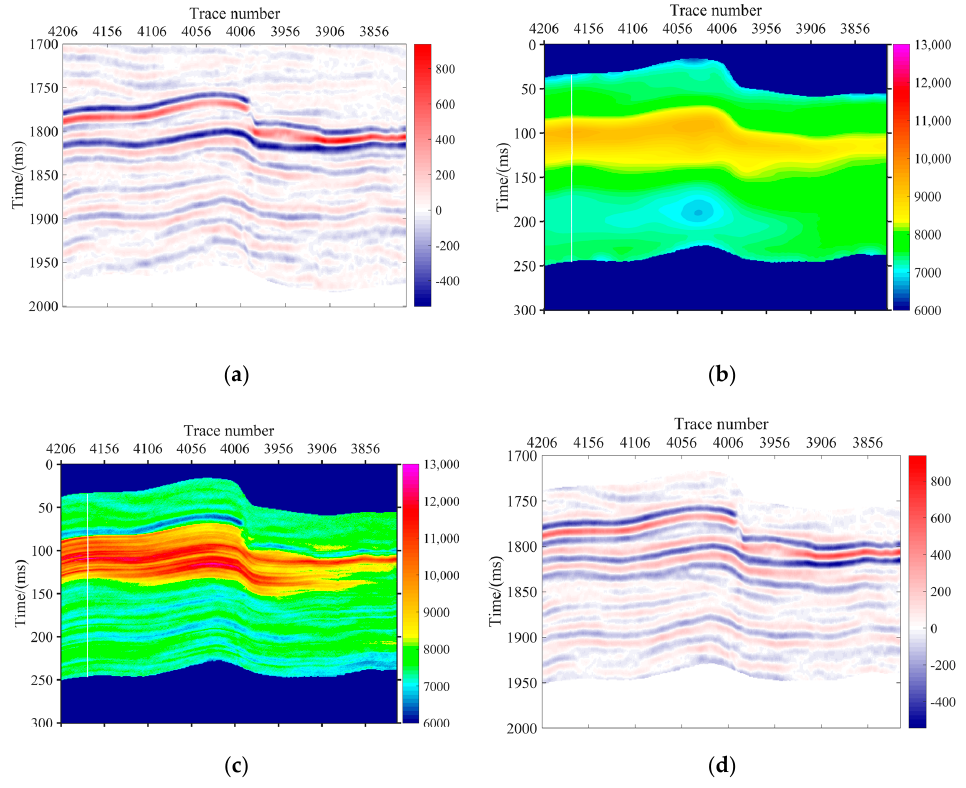
Figure 6. Field data. ( a ) Seismic record; ( b ) Initial impedance; ( c ) Inversion result of GMHDD and ( d ) Synthetic seismic data of GMHDD.